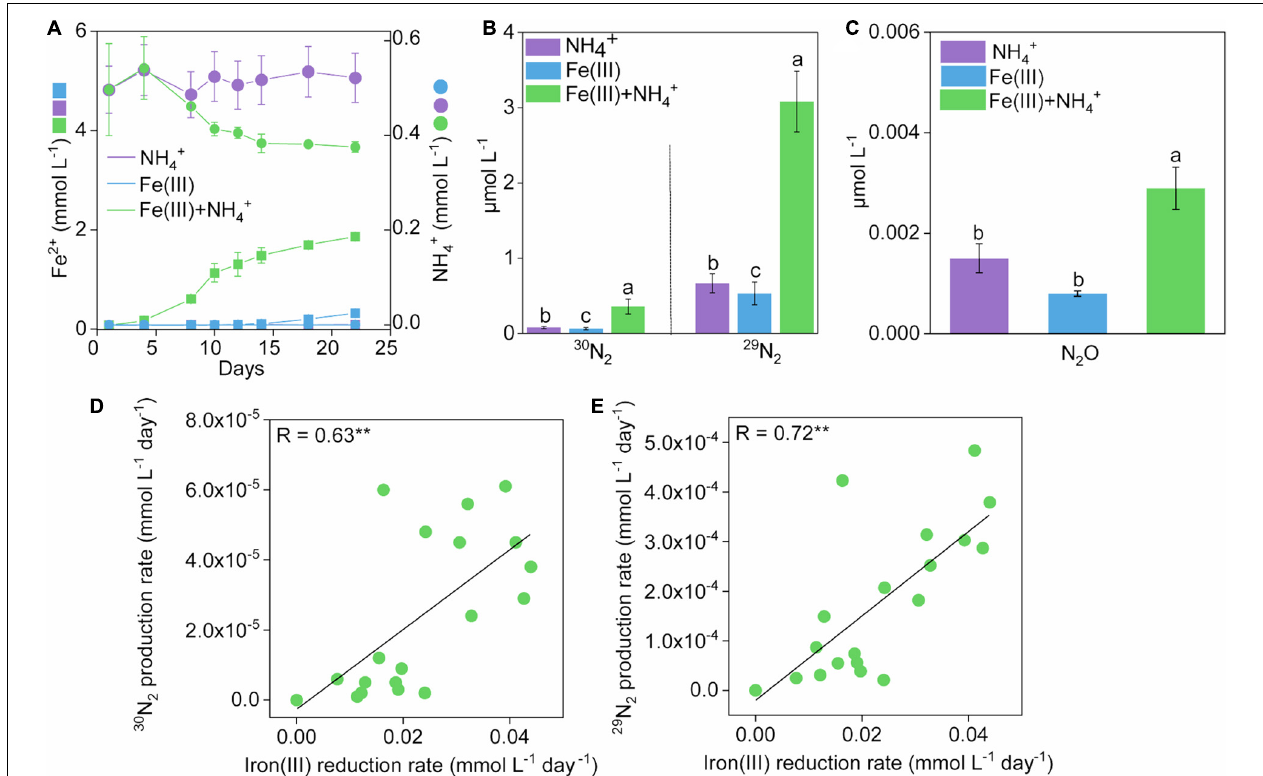
FIGURE 1 | Development of Fe(II), NH 4 + and N 2 production in treatments during 22-day incubation. Kinetics of Fe(II) (A) , NH 4 + (B) , and N 2 (C) production in treatments of NH 4 + , Fe(III), and Fe(III) + NH 4 + during 22-day incubation. Error bars represent standard deviations of three replications. The different lowercase letters above the error bar denote statistically significant ( p < 0.05) differences among different treatments. (D,E) The correlation between rates of iron(III) reduction and 15 N 2 production in treatments of Fe(III) + NH 4 + during 22-day incubation. “*” and “**” represent a statistically significant relationship between rates of iron(III) reduction and 15 N 2 production, which is denoted at p < 0.05 and p < 0.01, respectively.